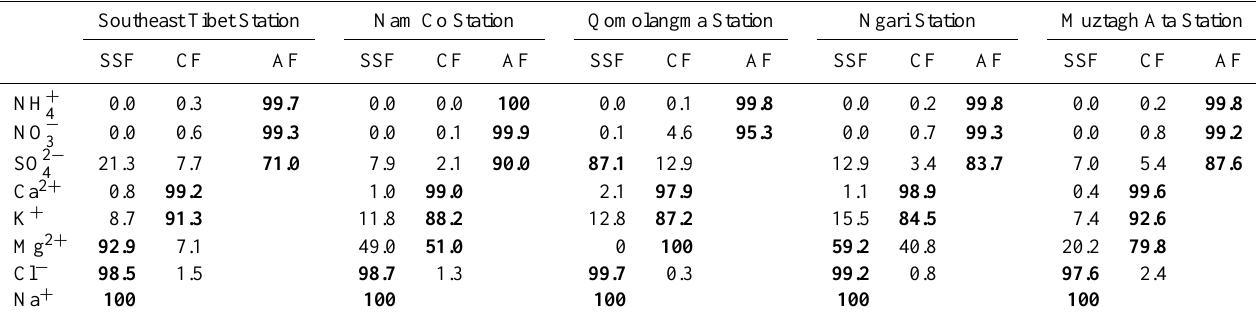
Table 5. Source contributions (%) for major ions in precipitation of five remote sites in the TP. SSF indicates sea salt fraction; CF indicates crust fraction; AF indicates anthropogenic fraction. Boldfaced values indicate the major contribution for each ion at each site. Southeast Tibet Station Nam Co Station Qomolangma Station Ngari Station Muztagh Ata